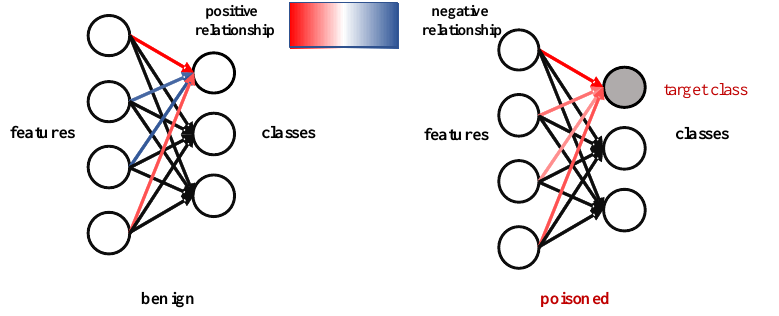
Figure 3. Comparison of the relationships between features and classes of benign models and backdoor models. For benign models, features have both positive and negative relationships with a prediction class, while for backdoor models, most features show a cooperative tendency in the classification of the target class. Features in relation to other classes are marked with black